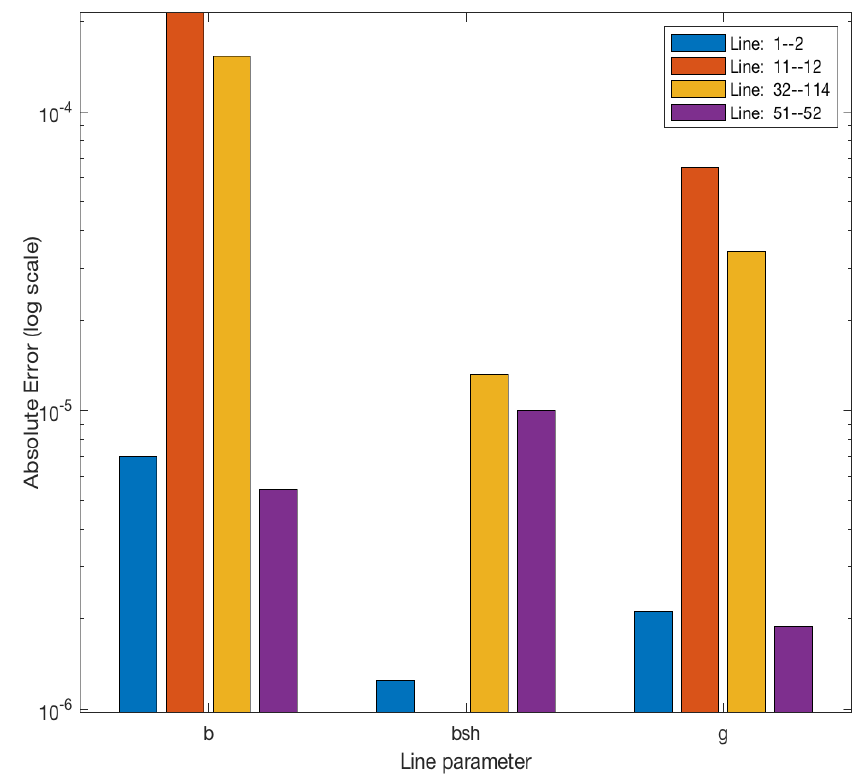
Figure 8. Absolute error of line parameter correction multiple line